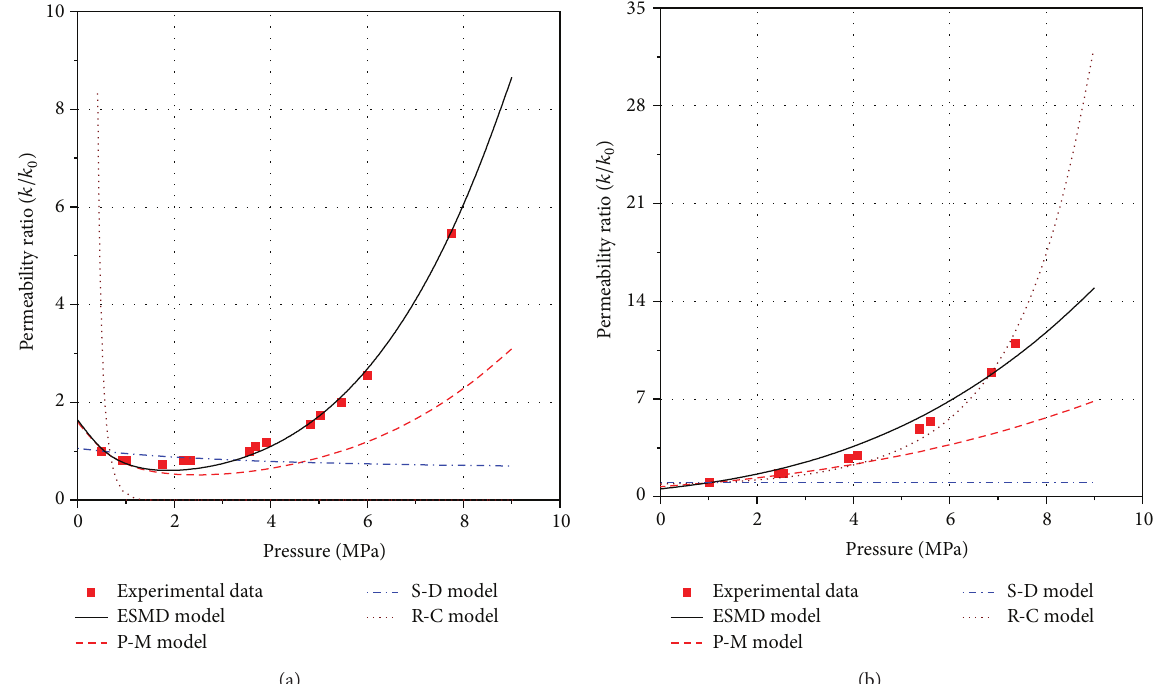
Figure 3: The comparison between permeability models and the experimental data.